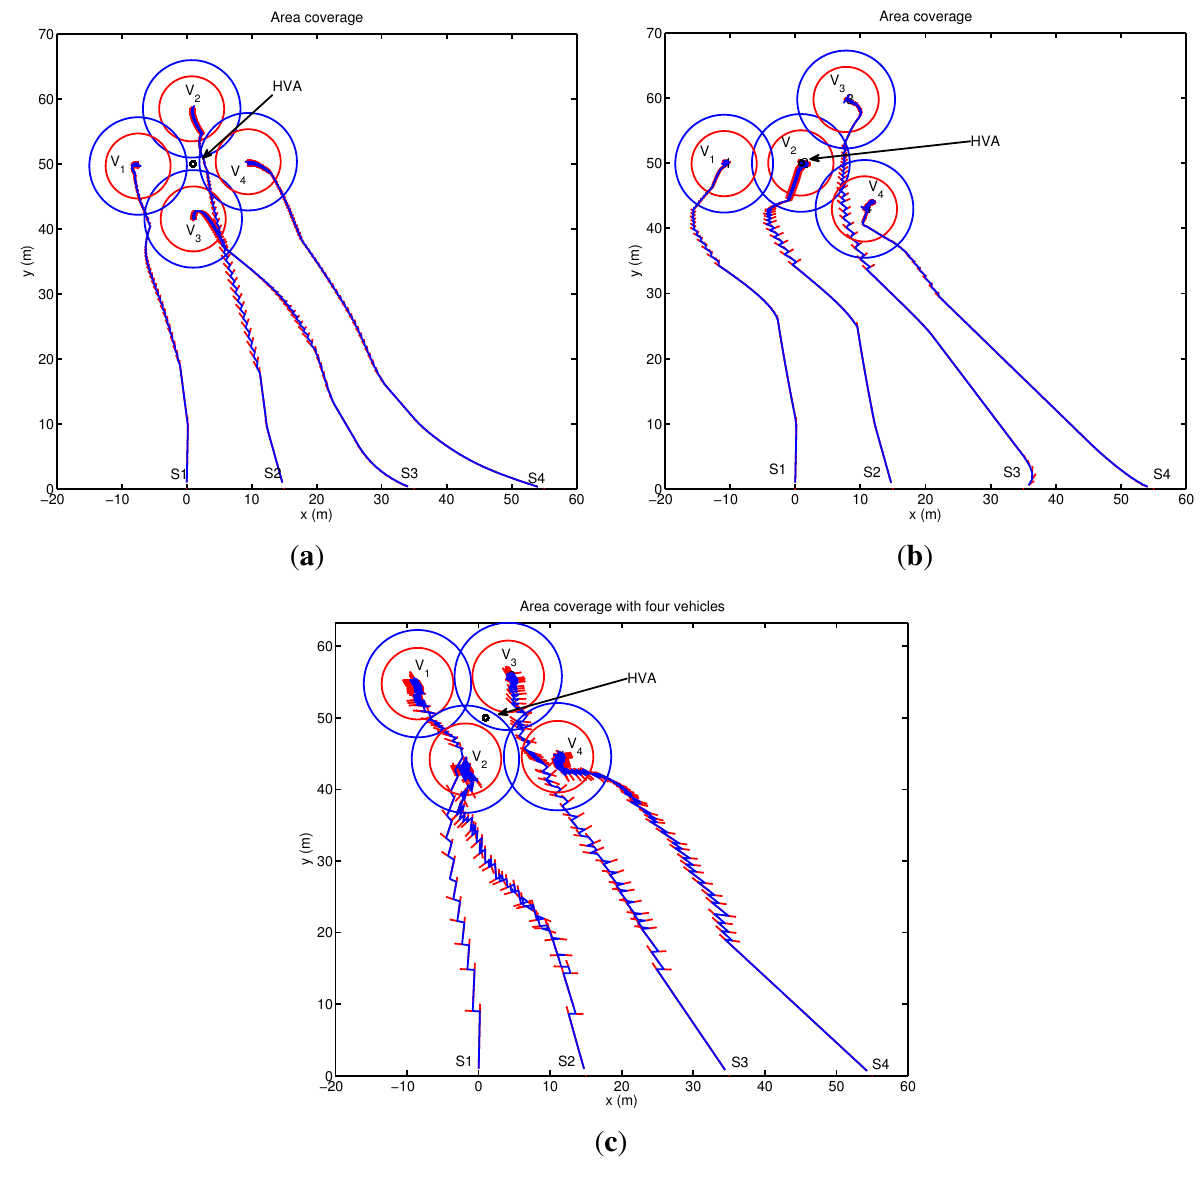
Figure 7. Area coverage with four vehicles. Increasing the number of vehicles different configurations can be obtained depending on the relative weight given to the two tasks. Top-Left: symmetric configuration obtained for N = 20 in h . Top-right: configuration with A one of the vehicle over the high value asset ( N = 10 ). Bottom: asymmetric configuration obtained by increasing the priority of task 2. As in the three vehicles case, the stability of this final stable configuration is related to the information communicated among the team members. In this case, when each vehicle communicates its foreseen location at its next communication step the asymmetric configuration becomes unstable and the group alternates between a configuration where V and V are further away than V and V and another one in 1 4 2 3 which V and V are closer than V and V to the asset. For each agent, bold lines are used to 1 4 2 3 depict both the maximum distance allowed R and the detection sonar maximum range R M D ( RM > RD ) . Red arrows indicate the vehicles